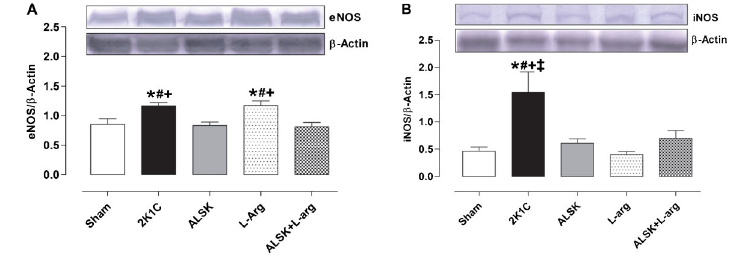
Figure 4. Effects of aliskiren (ALSK) and L- arginine (L-arg) treatment in renovascular hyper- tension on the densitometric analyses of Western blotting for endothelial nitric oxide synthase (eNOS) ( A ) and inducible nitric oxide synthase (iNOS) ( B ). Data are reported as means±SE. *P , 0.05 vs Sham; # P , 0.05 vs ALSK; { P , 0.05 vs L-arg; + P , 0.05 vs ALSK++L-arg (one-way ANOVA, followed by Fisher’s post hoc